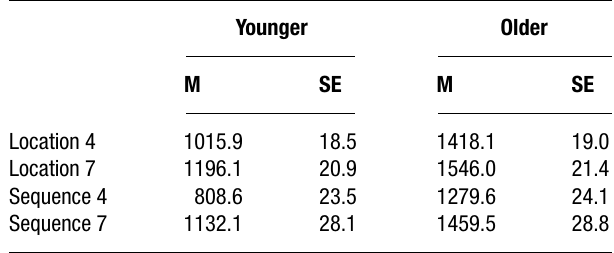
Table 4. SWM task: mean (M) correct reaction times (ms) and stand- ard errors ( ± 1 SE) as a function of load (set size 4 versus set size 7) and test (location memory versus sequence memory) in younger and older adults.